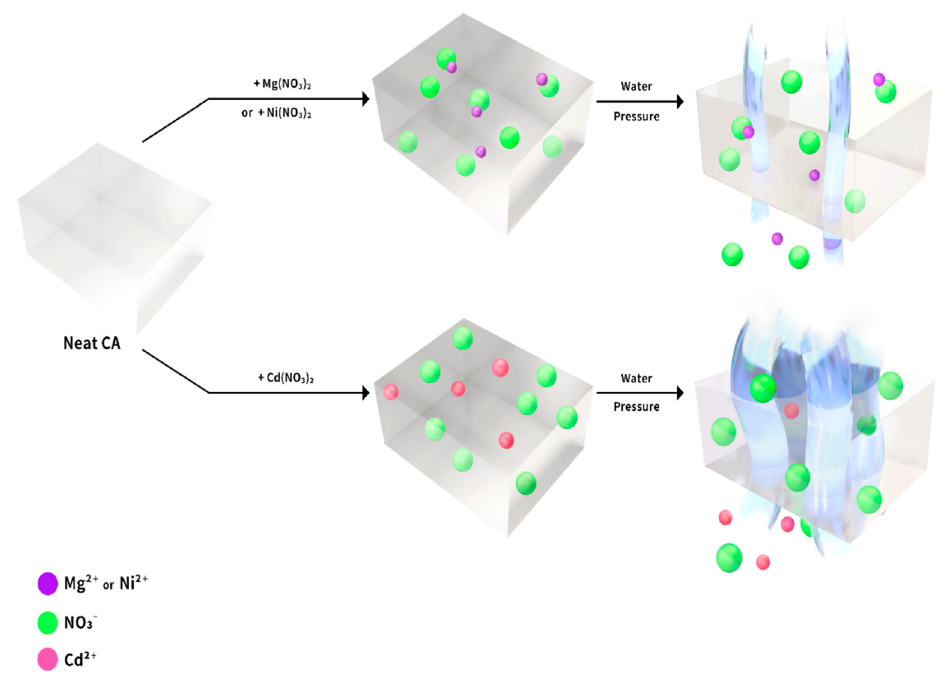
Scheme 1. Comparison of pore generation by species of metal salts in cellulose acetate.